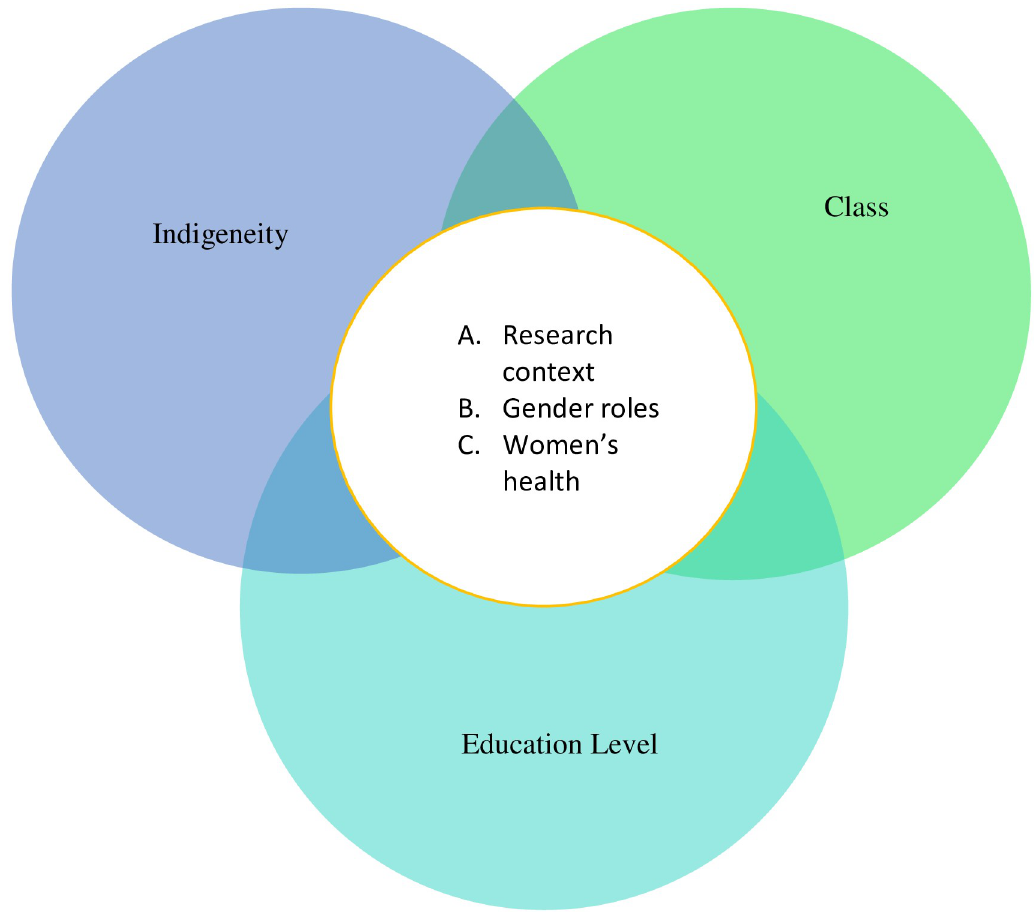
Fig 2. Visible areas across the empirical literature on Mexican women who remain behind. Edmonton, AB, Canada, 2020.